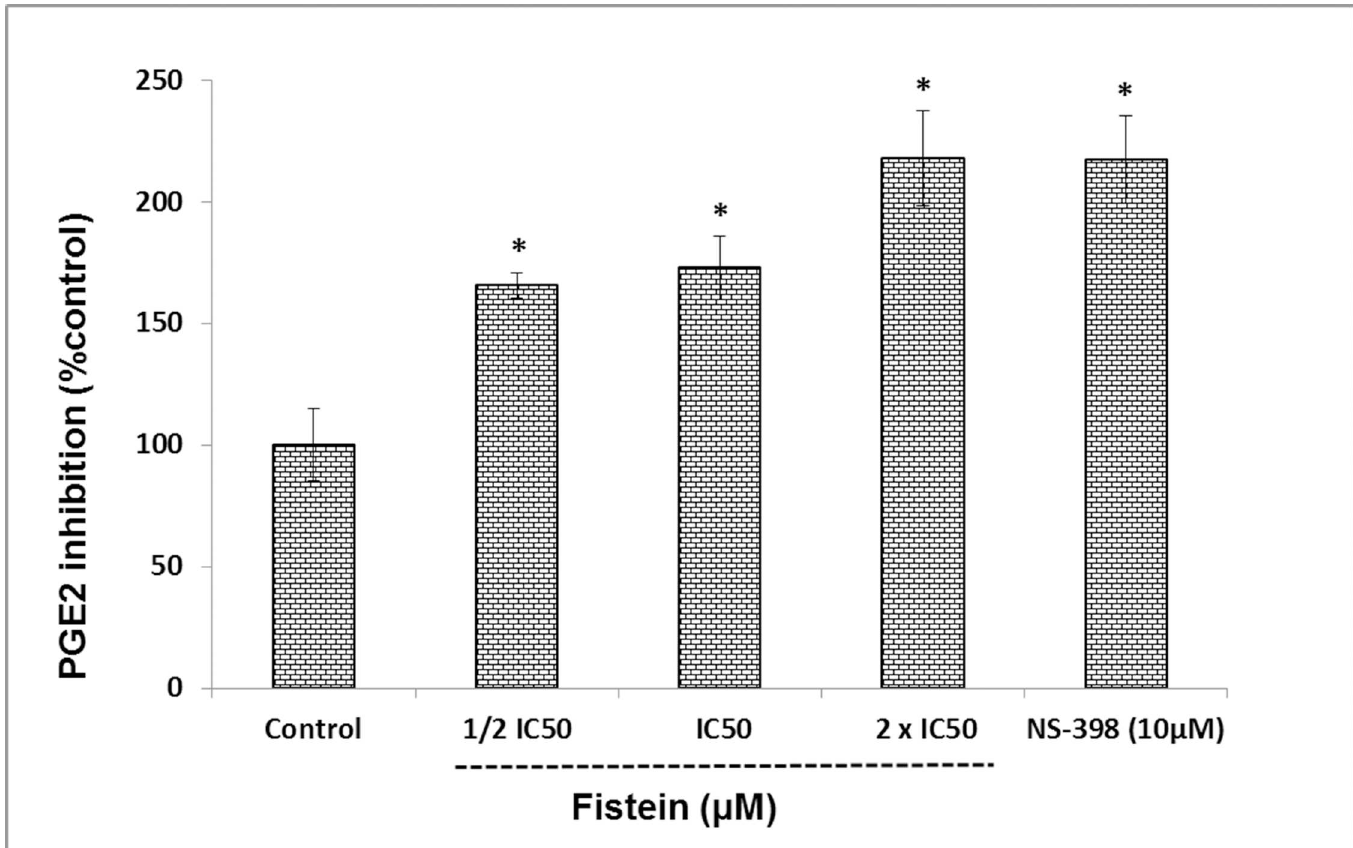
Fig 3. Inhibition of prostaglandin E2 after fisetin treatment of Caco-2 cells. Results are represented as mean value (M) ± S.E.M of at least three independentexperiments (4 replica each). * Significantly different from control group (P < 0. 05) using one way ANOVA